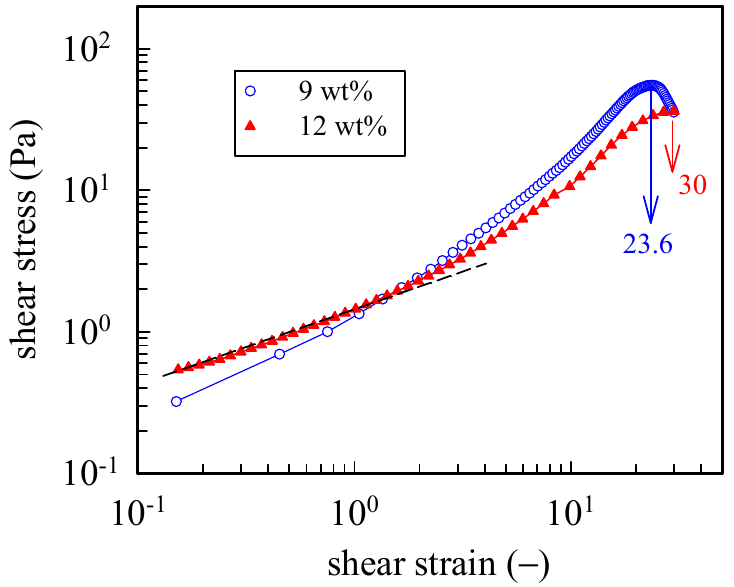
Figure 9. Startup of shear experiment of 9 wt% and 12 wt% a-PNIPAM hydrogels at a temperature 1 ◦ C higher than their T gel . For both gels, a constant shear rate of 0.05 s − 1 was applied up to a strain of